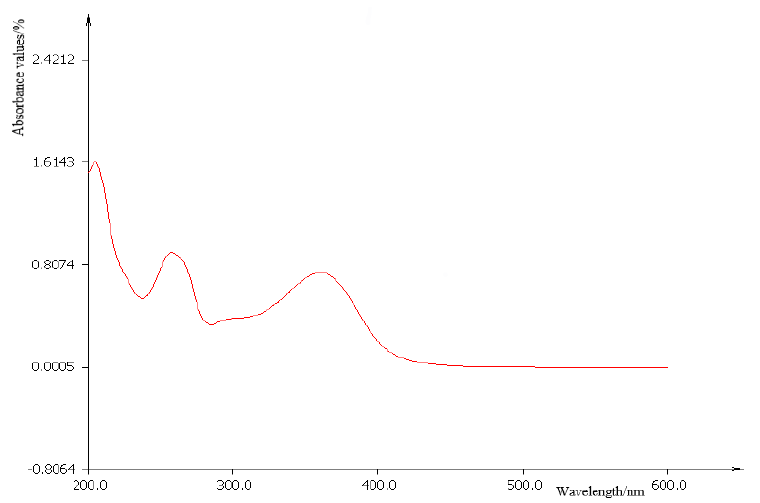
Figure 2. The ultraviolet spectrum of the rutin standard.